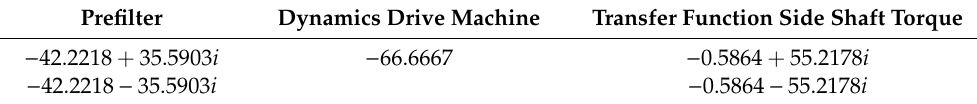
Table 3. Zeros of the Transfer function of the prefilter and the simplified real